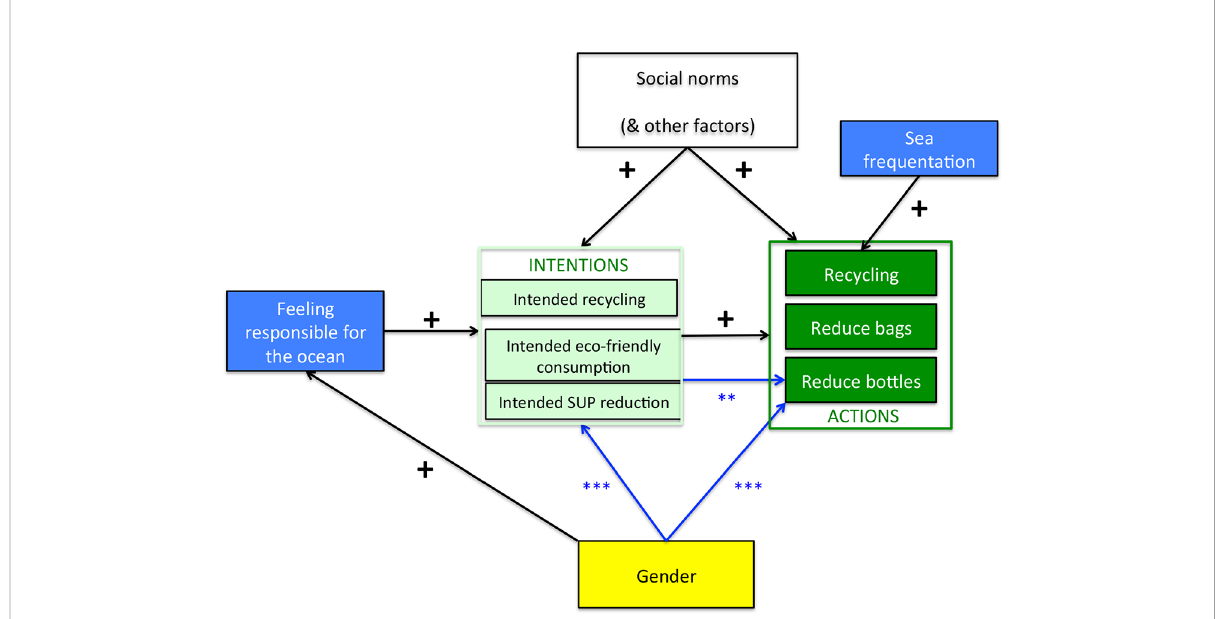
FIGURE 6 Schematic representation of the main signi fi cant relationships between marine citizenship components (sea frequentation and feeling responsible for the ocean, in blue boxes), pro-environmental intentions (light green), and behaviors (dark green) found in this study. Mediation effects are marked with blue arrows and direct effects with black arrows. **p < 0.01; ***p <